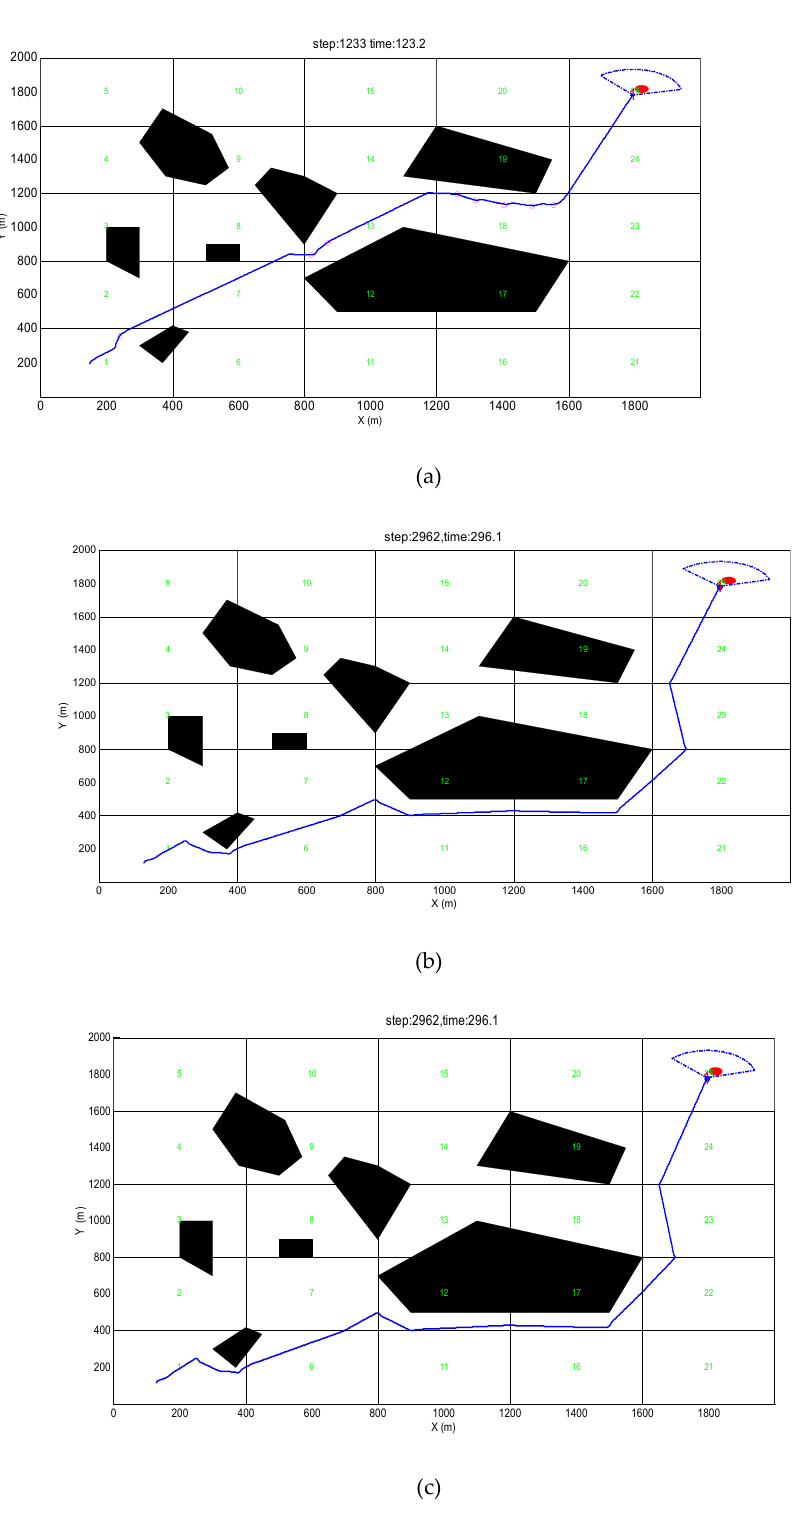
Figure 13. Simple obstacle environment avoidance trajectory. ( a ) PGOA (Predictive guidance obstacle avoidance). ( b ) APF (Artificial potential field). PSO (Particle swarm optimization).